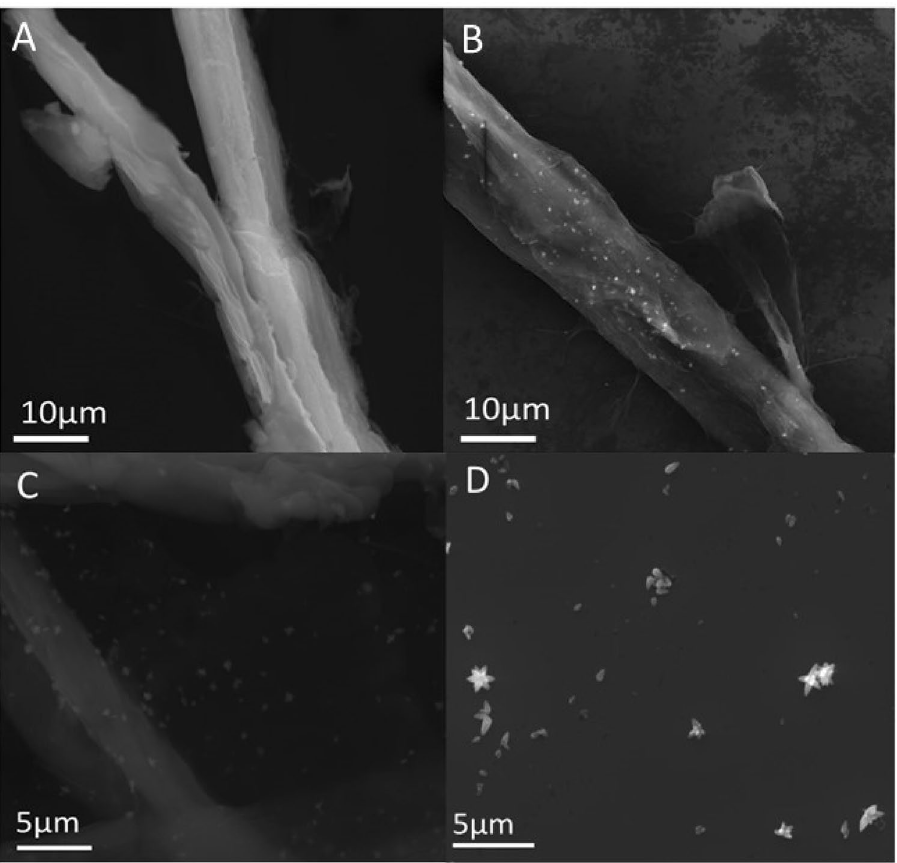
Figure 1. SEM images of pure cellulose fibers ( A ) and cellulose fibers functionalized with ZnO nanoparticles ( B , C ), ZnO nanoparticles after ball-milling of the composite ( D ).